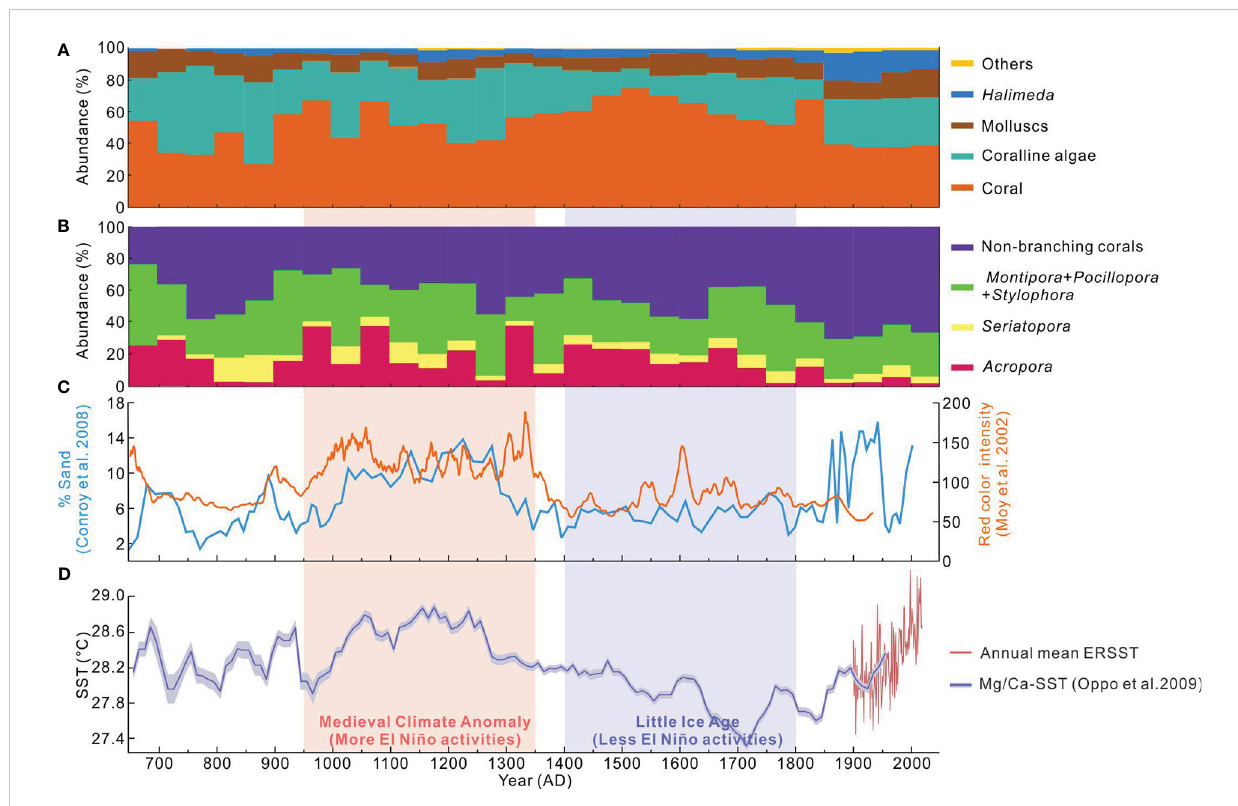
FIGURE 5 Paleo-ecological and paleo-climatic records: Abundances of (A) each bio-facies and (B) each coral genus, shown as the percent abundance of the total >2 mm sediment fraction and subfossil coral assemblage, respectively, for each 50-year interval (Tables 1 and 2); (C) Millennial-scale El Niño frequency timeseries from 50-year window width running mean of grayscale intensity in sediment cores from Laguna Pallacocha, southern Ecuador (Moy et al., 2002) and the grain size data from El Junco sediment cores, Gala ́ pagos (Conroy et al., 2008); and (D) Decadal-resolved SSTs reconstructed by foraminifera Mg/Ca proxy from the Makassar Strait (Oppo et al., 2009) and the annual mean ERSST